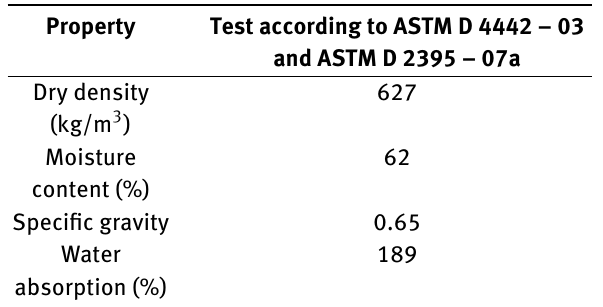
Table 3: Physical properties of sawdust particles.